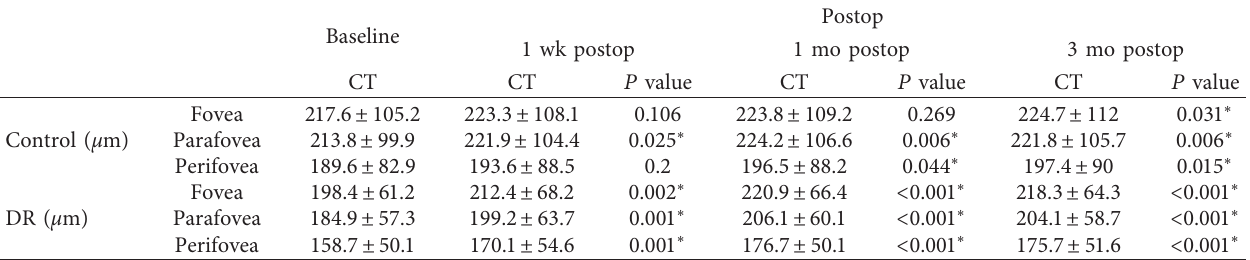
Figure 4: The choroidal thickness of fovea, parafovea, and perifovea for patients with mild/moderate NPDR (a) and nondiabetic patients (b) at four visits (mean ± SEM) W1: 1 wk postop; M1: 1 mo postop; M3: 3 mo postop. ∗ P < 0 . 05. Table 4: The choroid thickness of the patients with mild/moderate NPDR (DR) and nondiabetic patients (control) at four visits (mean ±